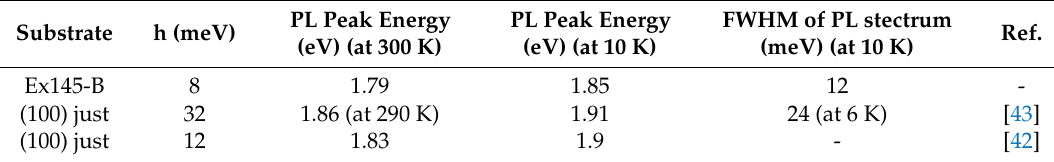
Table 4. Characterization of ordered GaInP epitaxial